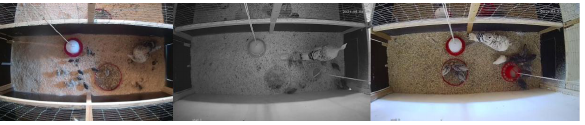
Figure 6. Different stages of chick growth. From left to right: small, medium, big. ©TiHo